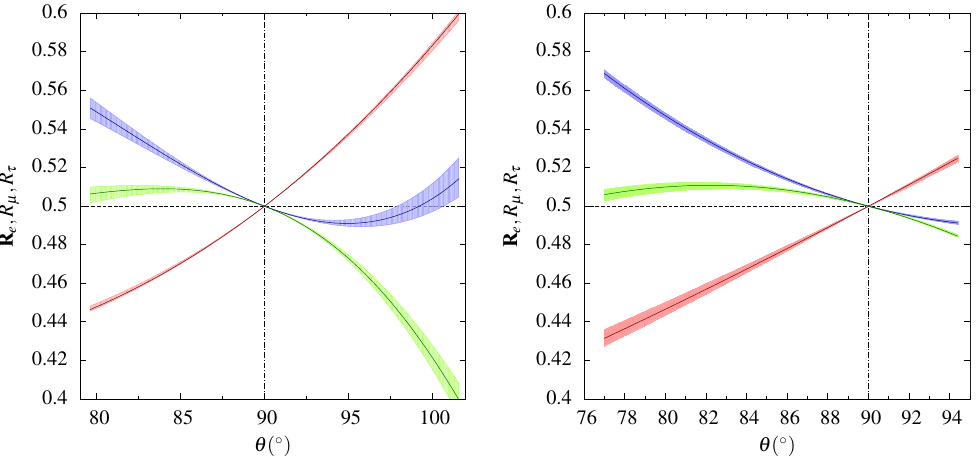
Figure 7 . Variation of the (cid:13)avor the (cid:13)ux ratios R e (red), R (cid:22) (blue) and R (cid:28) (green) with (cid:18) for NO (left panel) and for IO (right panel). The solid lines represent plots for the best-(cid:12)t values of the mixing angles and the bands are caused by the current 3 (cid:27) ranges of the mixing angles (cid:18) 12 and (cid:18) 13 . The horizontal axes in both plots correspond to the numerically obtained ranges of (cid:18) in table 2, which is di(cid:11)erent in NO and IO. For the NO case, (cid:17) 1 =(cid:17) 2 is (cid:12)xed at 1 :